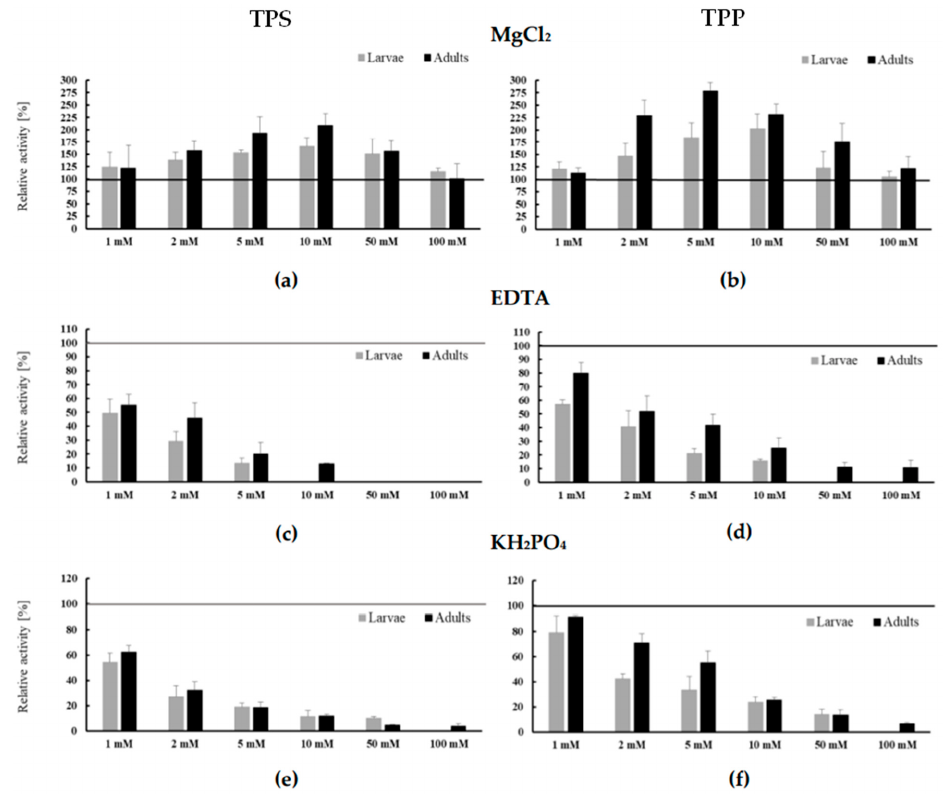
Figure 5. Influence of different concentrations of effectors on the activity of trehalose-6-phosphate synthase (TPS) and trehalose-6-phosphate phosphatase (TPP); ( a ) The activities of TPS control samples without effector—MgCl 2 (Mg 2+ ) (459.19 ± 84.21 U/mg for larvae and 206.7 ± 29.79 U/mg for adults) were taken as 100%; ( b ) The activities of TPP control samples without effector—MgCl 2 (Mg 2+ ) (635.98 ± 59.28 U/mg for larvae and 240.38 ± 5.6 U/mg for adults) were taken as 100%; ( c ) The activities of TPS control samples without effector—EDTA (815.08 ± 180.04 U/mg for larvae and 600.01 ± 60.5 U/mg for adults) were taken as 100%; ( d ) The activities of TPP control samples without effector—EDTA (549.58 ± 117.67 U/mg for larvae and 347.69 ± 105.38 U/mg for adults) were taken as 100%; ( e ) The activities of TPS control samples without effector—KH 2 PO 4 (Pi) (595.47 ± 62.9 U/mg for larvae and 251.53 ± 29.94 U/mg for adults) were taken as 100%; ( f ) The activities of TPP control samples without effector—KH 2 PO 4 (Pi) (704.94 ± 58.52 U/mg for larvae and 310.84 ± 18.13 U/mg for adults) were taken as 100%; ( a – f ) Mean ± SD; n = 9.